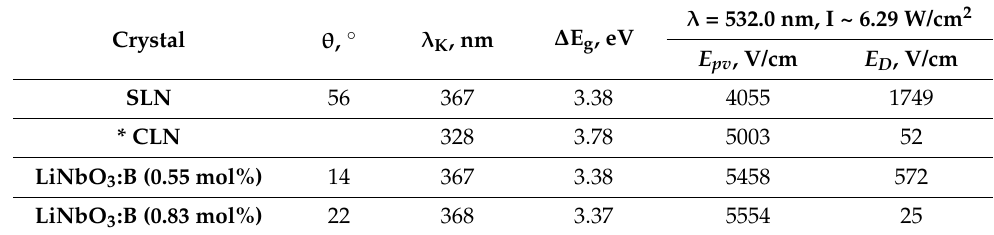
Table 3. Photoelectric PILS parameters and bandgap of LN crystals at T = 25 ◦ C. Table is reproduced with the permission of Pleiades Publishing from papers N. V. Sidorov et al., Techn. Phys. 2020 V. 65 P. 627–634, DOI: https://doi.org/10.1134/S1063784220040192 (accessed on 26 March